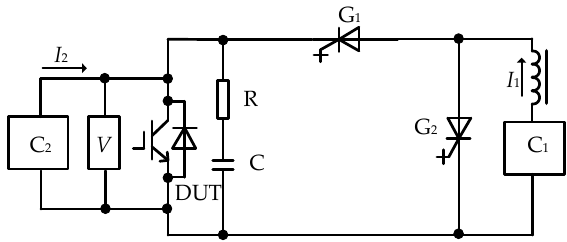
Figure 2. Schematic diagram of single-directional accelerated fatigue test.